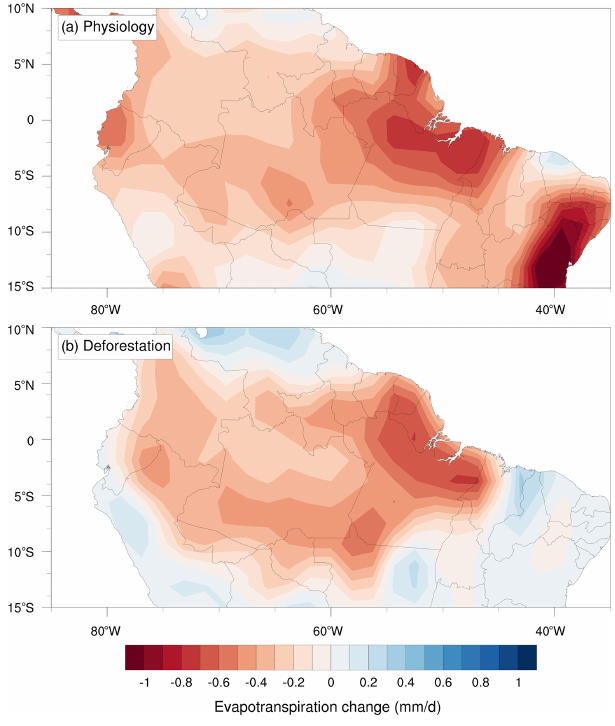
Figure 4. Annual mean changes in evapotranspiration in trop- ical South America (a) under an atmospheric concentration of + 200ppmv (1.5 × CO 2 ) affecting solely surface vegetation physi- ology and (b) with the complete substitution of the Amazon forest by pasture